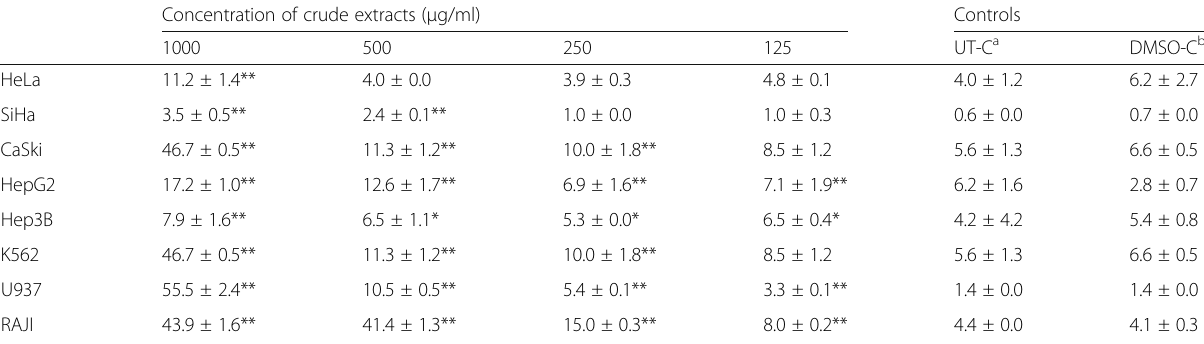
Table 3 The average (±SD) percentages of cells in the sub-G1 phase obtained from the histogram of PI staining with statistical analysis Concentration of crude extracts ( μ g/ml)